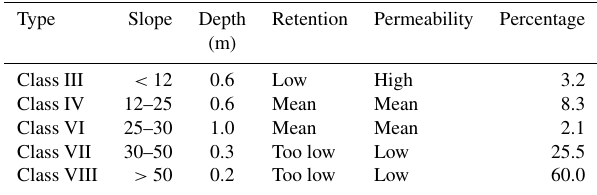
Table 1. Description of the soils in the region (Osorio,